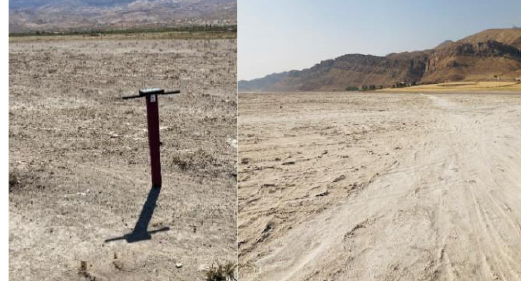
Figure 2 . Top photo, TDR 350 device for In-situ data collection, Bottom photo, a general view of the study area.